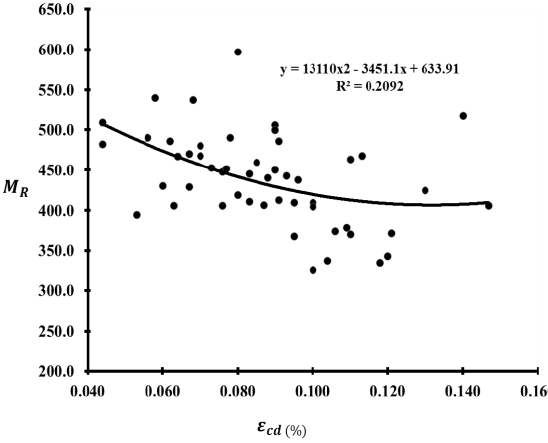
Fig. 12. Relationship between M Figure 12: Relationship between M